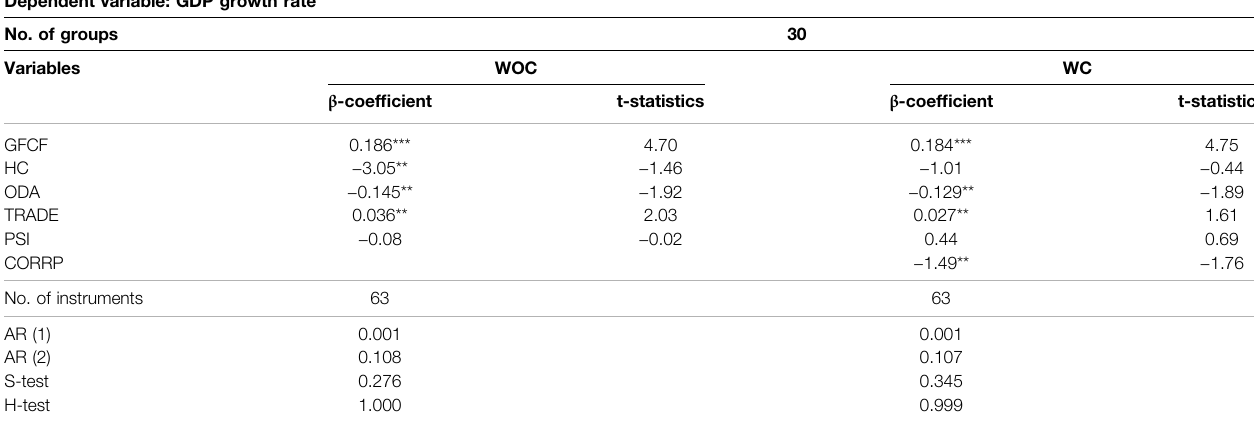
TABLE 9 | Results of difference GMM for most corrupt economies.